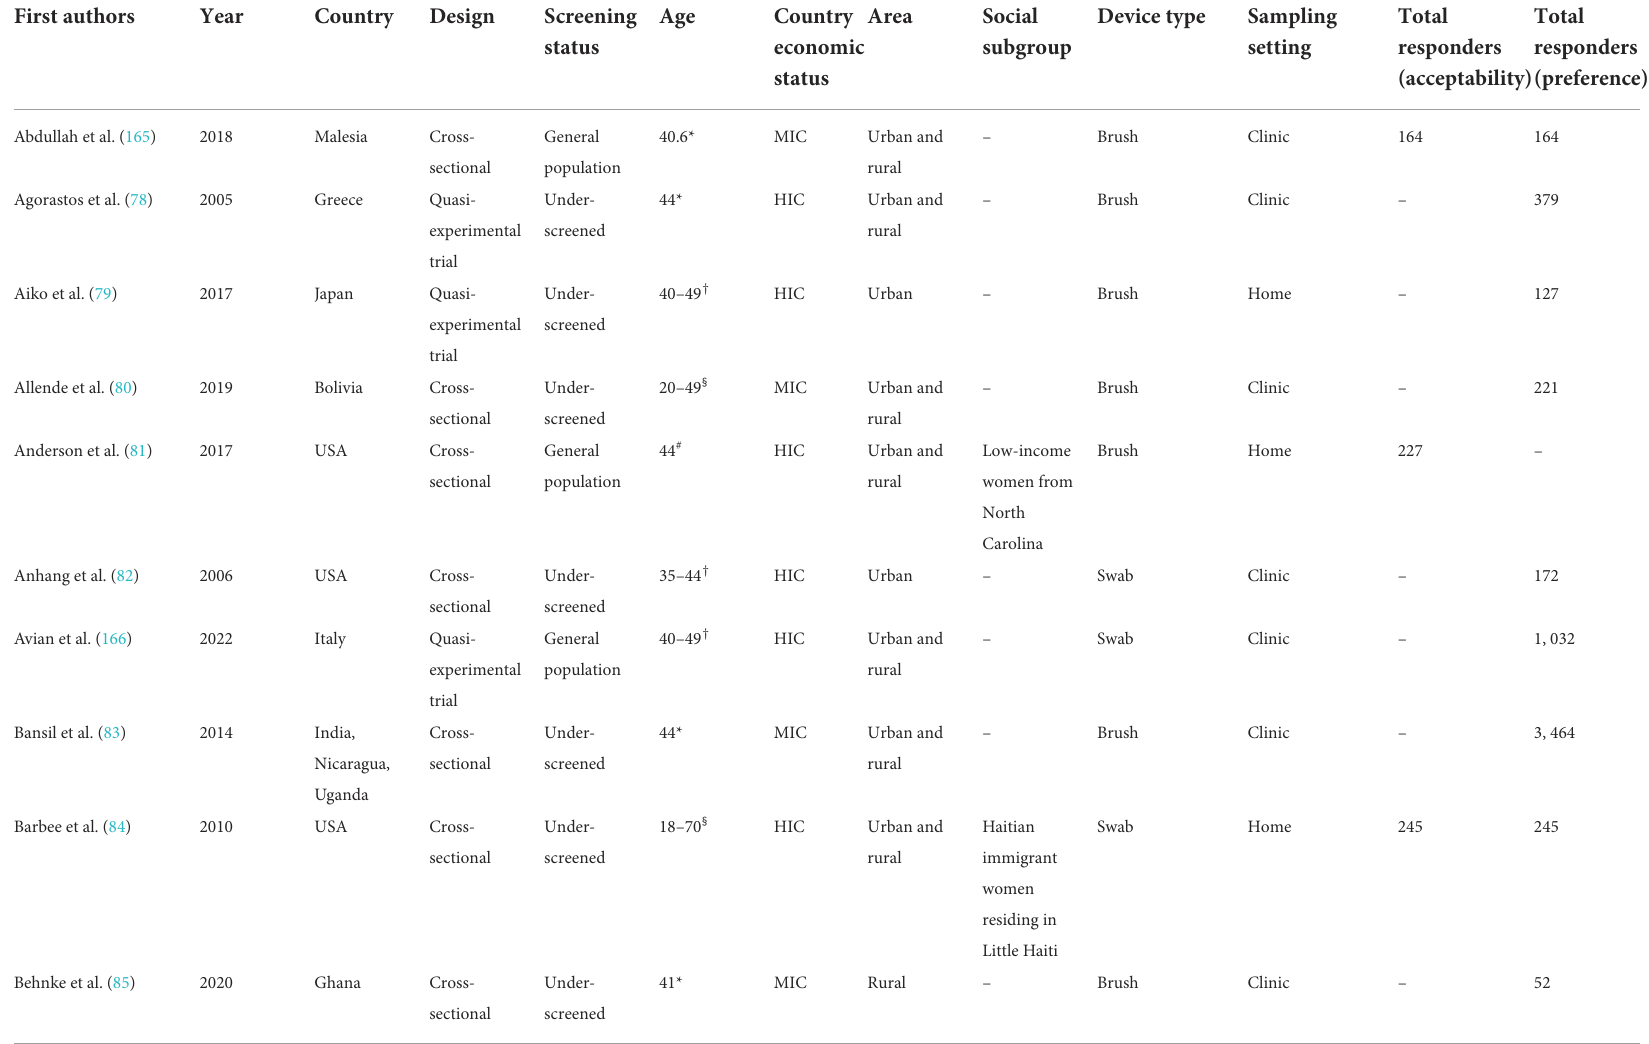
TABLE 4 Characteristics of the included studies assessing acceptability and preference of self-sampling vs. clinician-collected